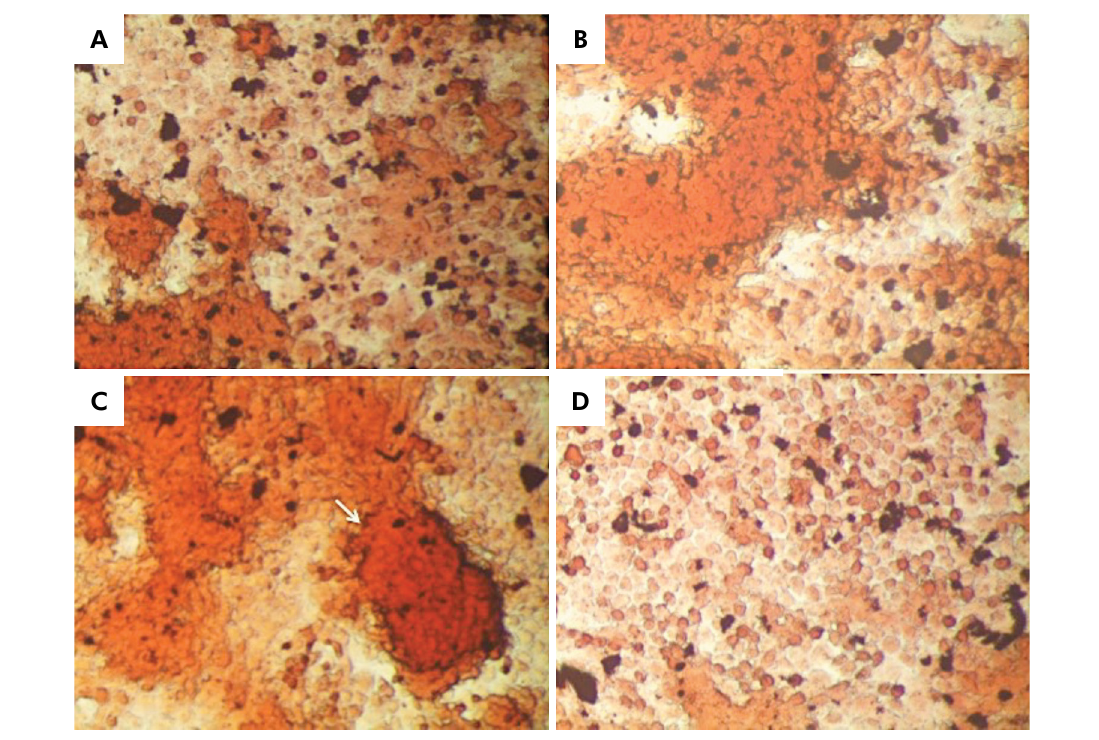
Figure 5. Representative images of alizarin red staining showing mineralization ability of Saos-2 cells after 13 days of taxifolin treatment. A: Control DMEM with µM DMSO, B: T10-24h, C: T10-72h, and D: T10-CT. White arrows show mineralized nodules. (Light microscopy, 4X).